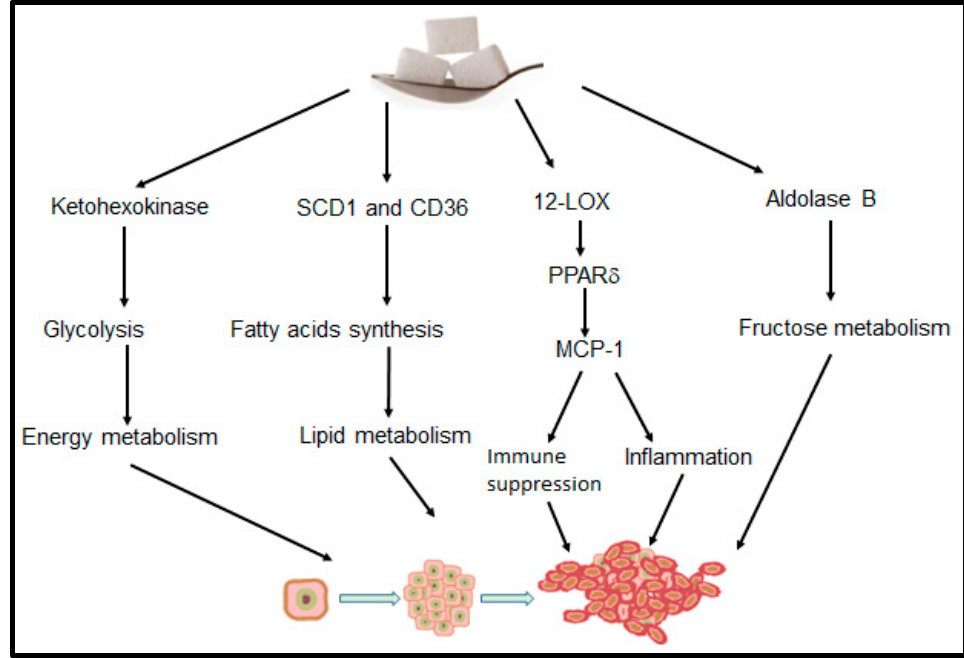
Figure 2. Proposed model whereby dietary sugar influences multiple cancer-specific pathways, including energy metabolism, lipid metabolism, inflammation, and immune function.